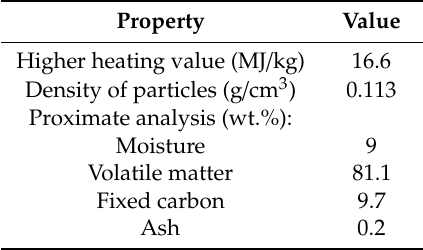
Table 1. Properties of pine wood